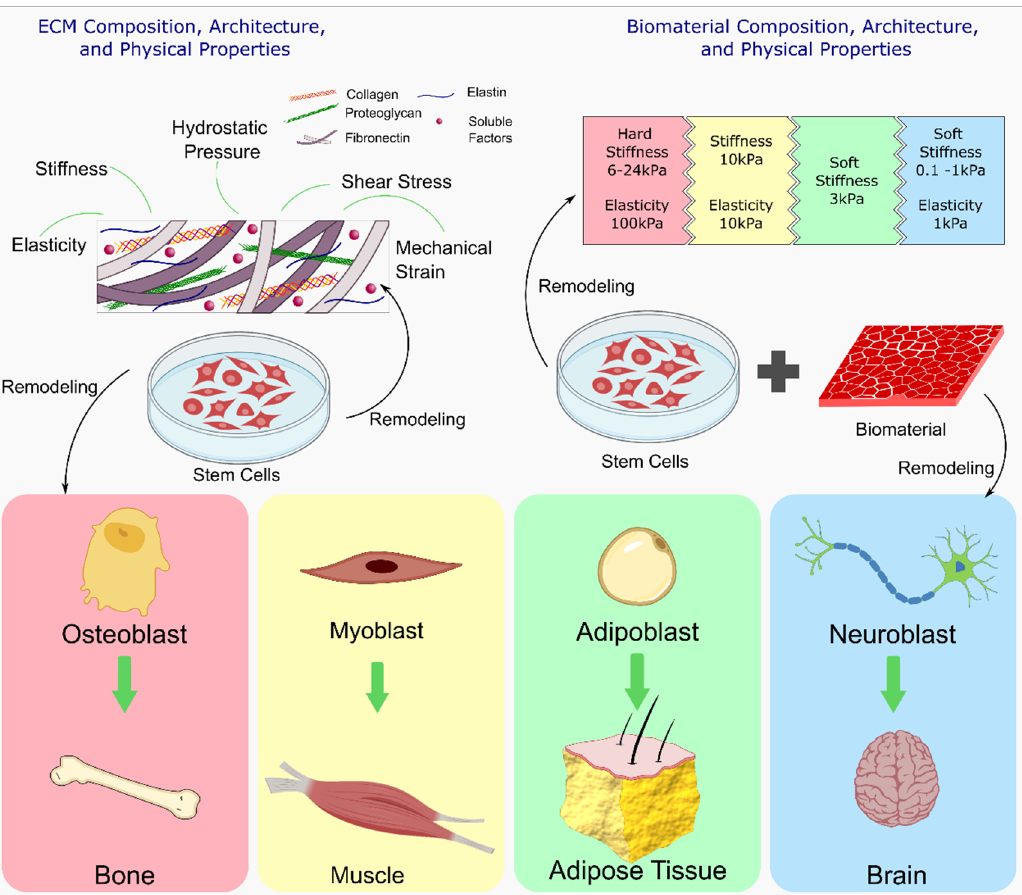
Figure 11. Schematic of the interaction between stem cells and ECM and its effect on ECM properties along with pathways that determine cell fate. The different biomechanical properties of the ECM promote differentiation of cells towards tissue specific lineages and is dependent on the composition, architecture, microstructure, and the various cues within the ECM (Modified and reproduced with permission from Ref. [171] under Creative Commons Attribution License (CC BY)).